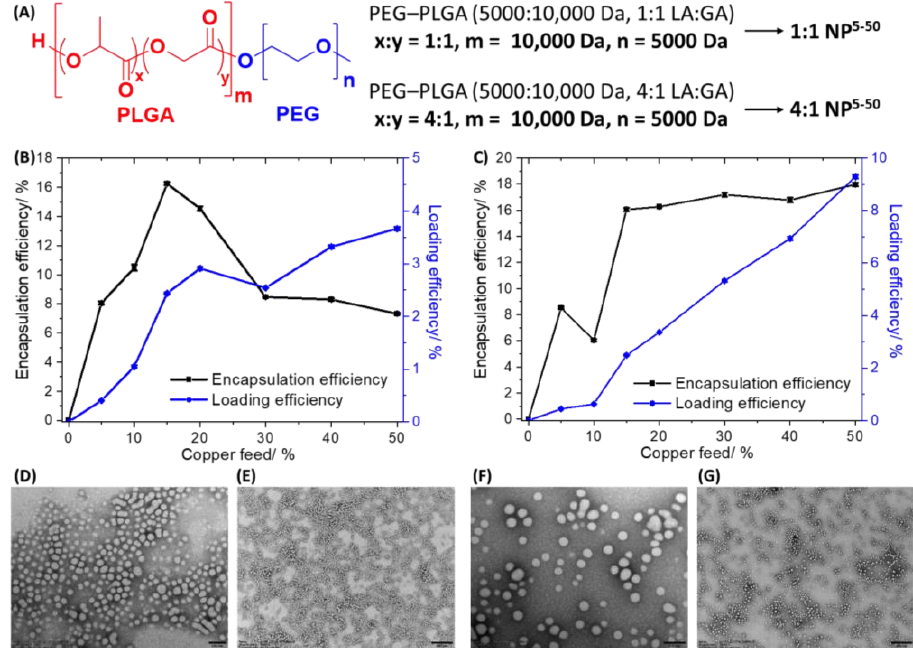
Figure 2. ( A ) Chemical structures of PEG – PLGA (5000:10,000 Da, 1:1 LA:GA) and PEG – PLGA (5000:10,000 Da, 4:1 LA:GA) polymers and the nomenclature used to describe the PEG – PLGA nanoparticles formulations prepared with the various feeds of 1 . The effect of feed variation on encapsulation and loading efficiency of 1 incorporated into ( B ) PEG – PLGA (5000:10,000 Da, 1:1 LA:GA) or ( C ) PEG – PLGA (5000:10,000 Da, 4:1 LA:GA) nanoparticles. TEM images of 1:1 NP 15 suspended in water at ( D ) ×40,000 magnification, scale bar = 100 nm and ( E ) ×10,000 magnification, scale bar = 500 nm. TEM images of 4:1 NP 15 suspended in water at ( F ) ×50,000 magnification, scale bar = 100 nm and ( G ) ×10,000 magnification, scale bar = 500 nm.